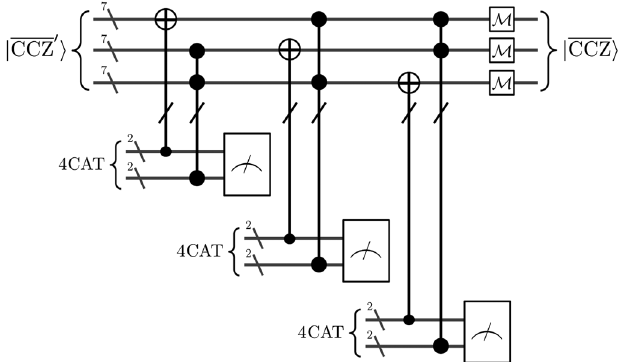
FIG. 11. The postselected verification of the potentially faulty j CCZ 0 i state that is output from the non-fault-tolerant preparation in Fig. 8. The slashed CX and CCZ gates are controlled on the 4CATs as shown in Fig. 9(b) and targeted as transversal X and transversal CZ on the encoded blocks. The 4CAT inputs are prepared as in Fig. 9(a) and the measurement boxes on the 4CATs represent Fig. 9(c). We use M to represent measurement of all 7- qubit code stabilizers using Steane states, Fig. 10(a). In this case, a successful postselection occurs upon a trivial syndrome from all M and from the CAT measurements. The total circuit volume is 34